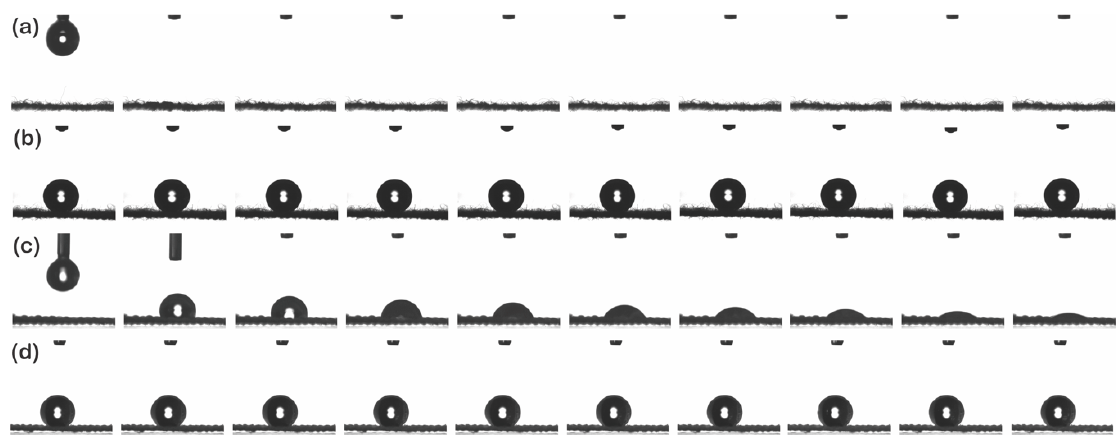
Figure 4. Photographs of water droplets on the surface of the untreated ( a ) and P1T1 PDMS-coated staple fabrics ( b ), untreated ( c ) and P1T1 PDMS-coated filament fabrics ( d ).